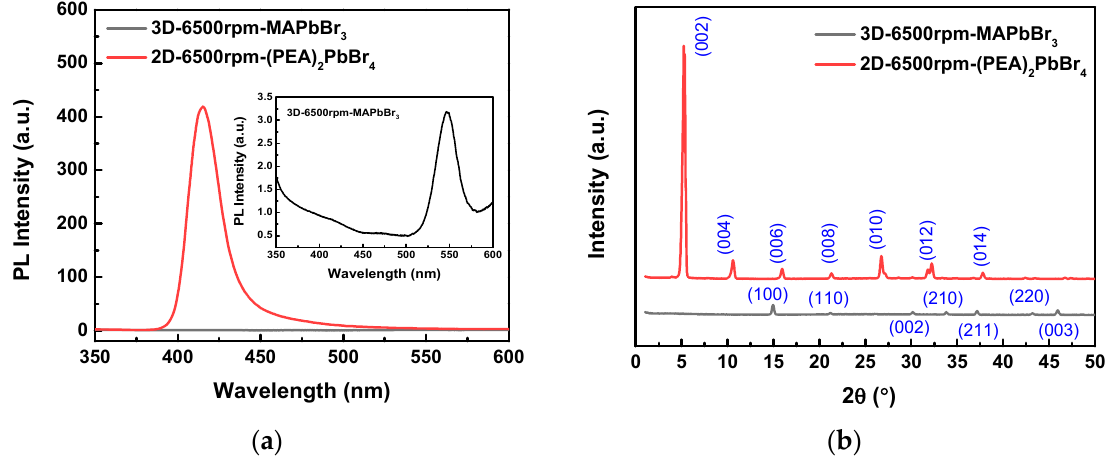
Figure 5. Comparison of ( a ) photoluminescence (PL) intensities and ( b ) X-ray diffraction (XRD) pat- terns of 3D-6500rpm-MAPbBr 3 and 2D-6500rpm-(PEA) 2 PbBr 4 perovskites. From the above results, it was found that 2D-6500rpm-(PEA) 2 PbBr 4 showed a better response to the vapor than 3D-6500rpm-MAPbBr 3 . This result was also proved by the SEM, PL, and XRD observations. The crystal structure of 2D-6500rpm-(PEA) 2 PbBr 4 was of good quality, the distribution was finer and more uniform, which increased the reaction area of the film. In contrast, the 3D-6500rpm-MAPbBr 3 perovskite had relatively large crystal and thin film inhomogeneities, resulting in poor performance for vapor sensing. In order to improve the sensitivity of 2D-(PEA) 2 PbBr 4 perovskite vapor sensing, we fur- ther explored the effect of 2D-(PEA) 2 PbBr 4 perovskite vapor sensing under different spin coating conditions.